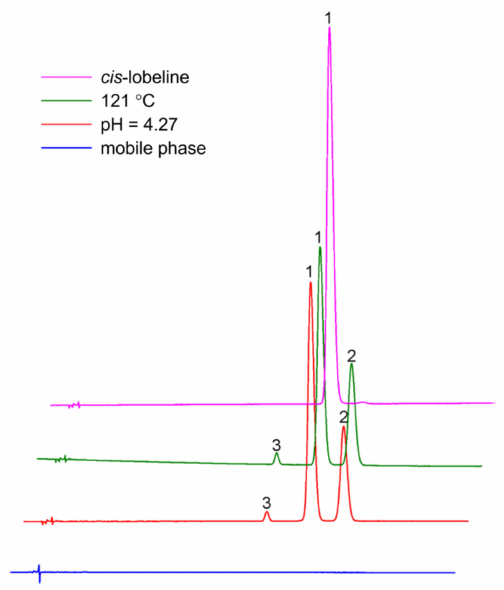
Figure 2. Representative chromatograms to evaluate the separation effect of isocratic elution methods. 1 = cis -lobeline, 2 = trans -lobeline, 3 =